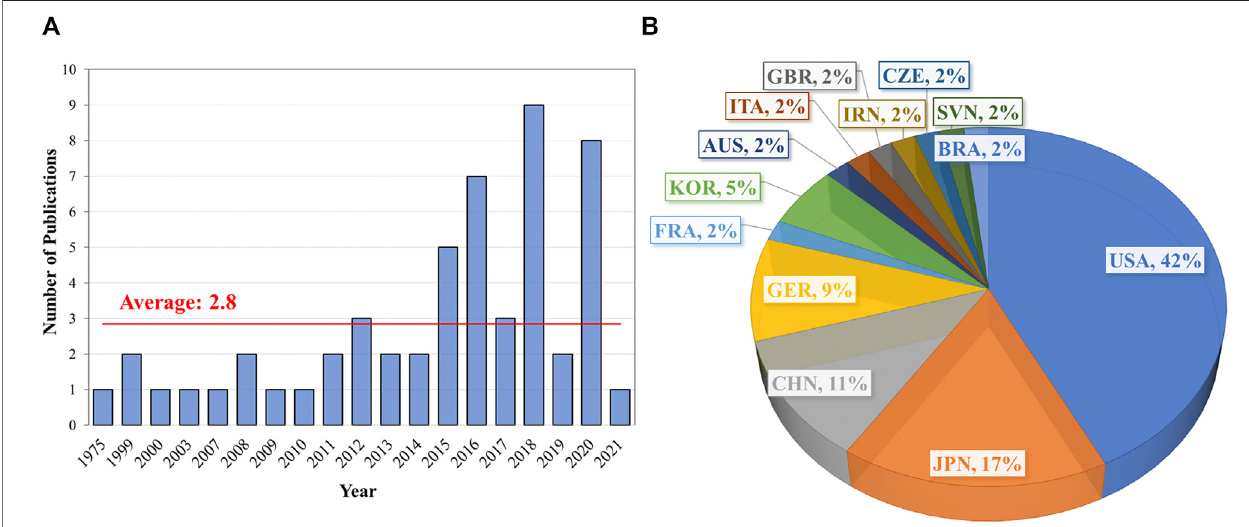
FIGURE 4 | Timeline and distribution of studies by geography investigating the antiviral effects of NTP (data for 2021 includes publications as of March 10, 2021). The number of studies utilizing NTP for antiviral applications increased over the last ten years (A) and were predominantly performed in the United States (B) . Abbreviations:AUS:Australia;BRA:Brazil;CZE:CzechRepublic;CHN:China;FRA:France;GER:Germany;GBR:GreatBritain;IRN:Iran;ITA:Italy;KOR:SouthKorea; SVN: Slovenia; USA: United States of